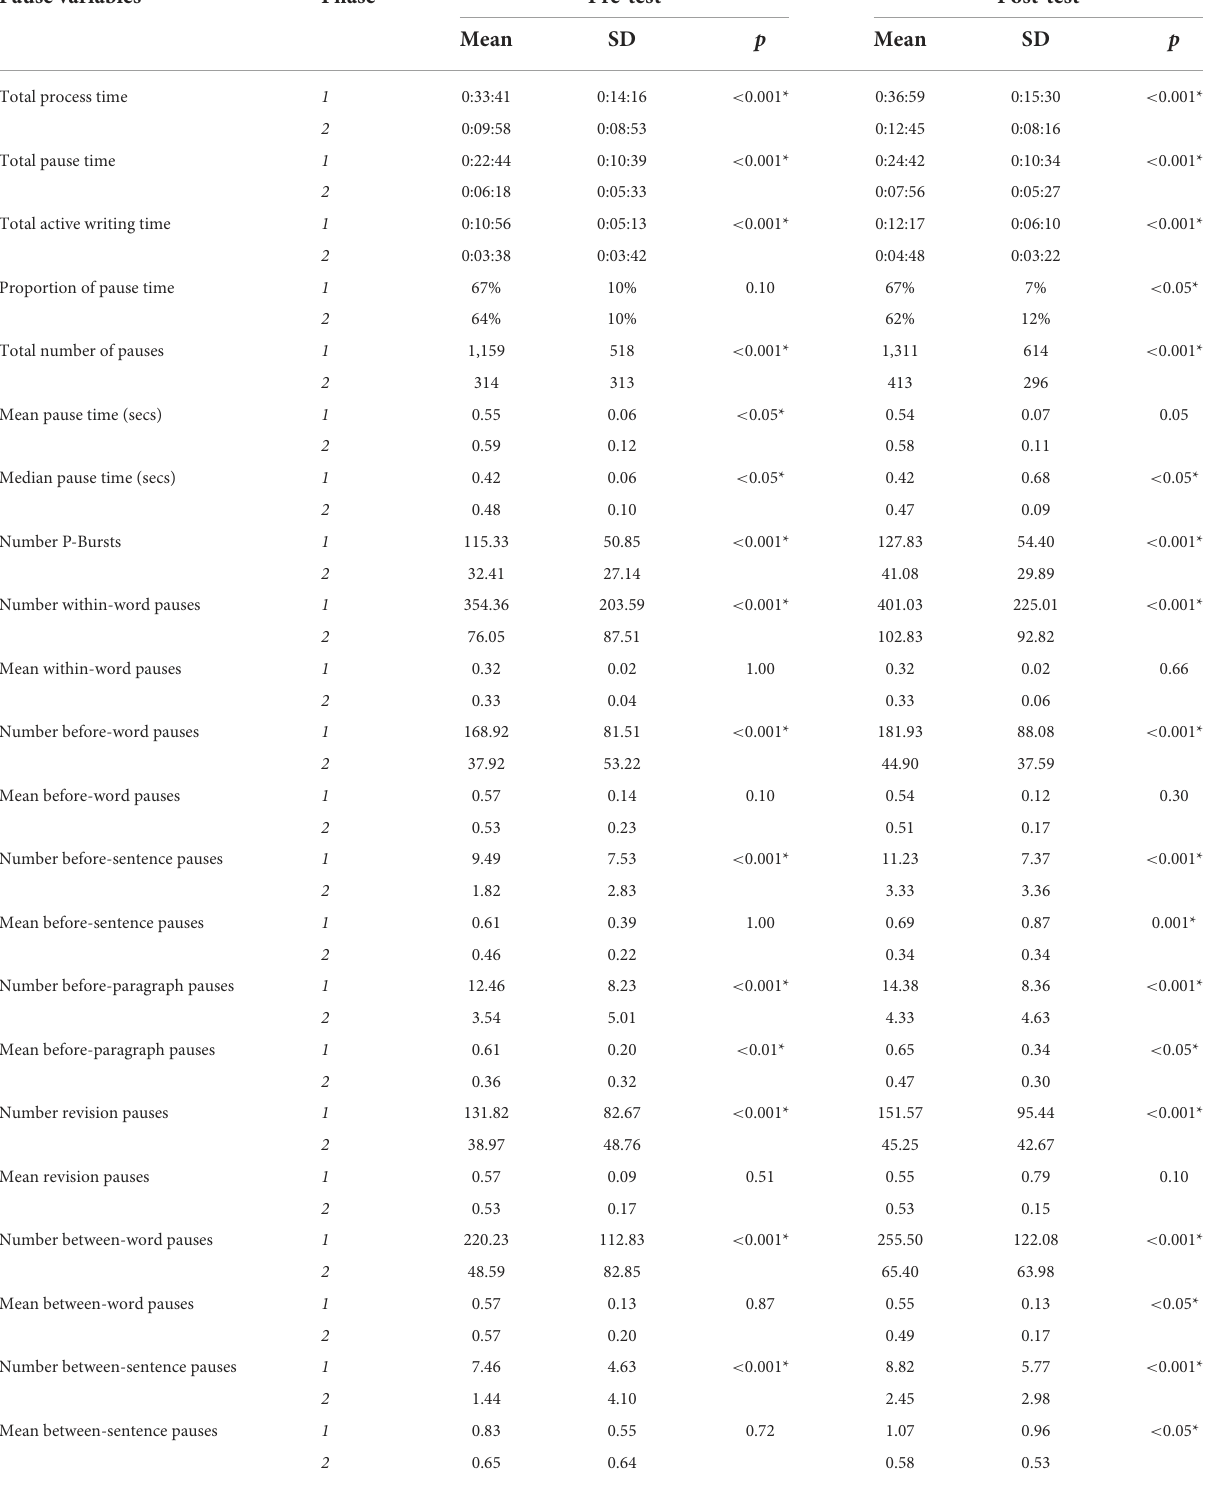
TABLE 1 Pausing behavior across writing